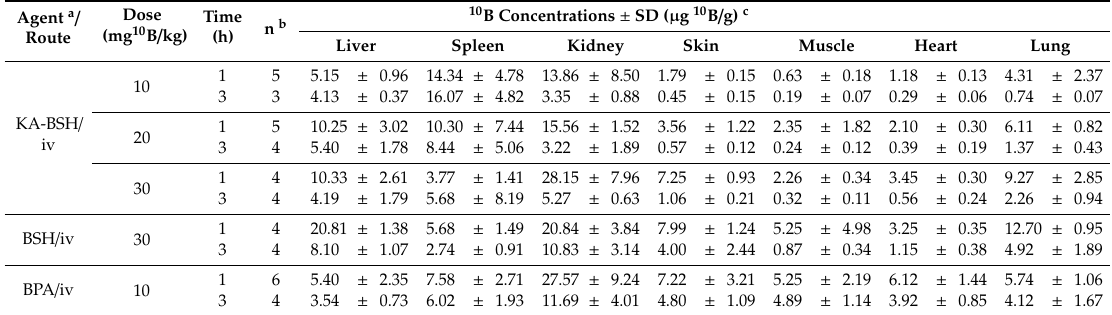
Table A1. Boron concentrations in normal tissue in F98 glioma bearing